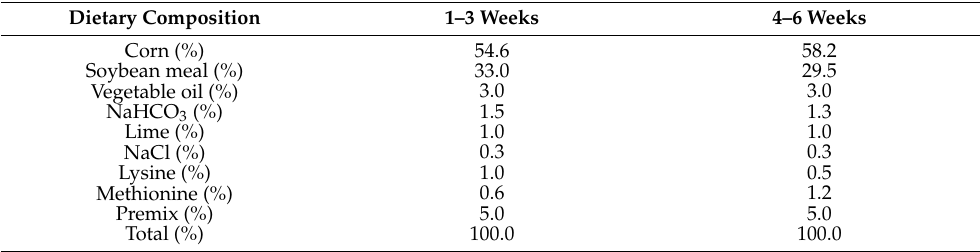
Table 1. Basic diet composition. Dietary